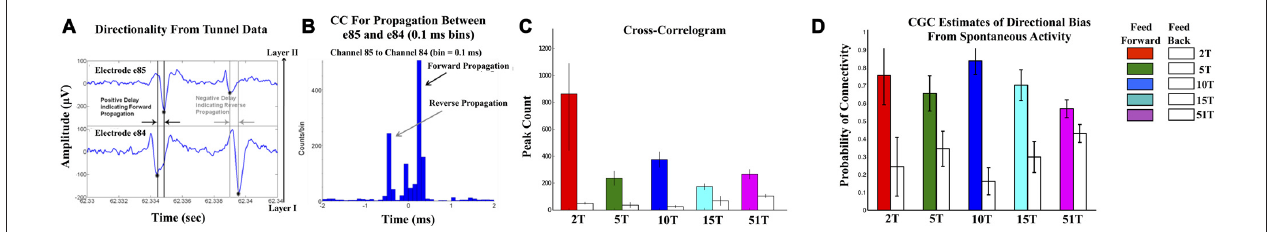
FIGURE 3 | Confirmation of Feed-Forward functional connectivity between Layers I and II. (A,B) illustrate the computation of correlation metric (CC) in which the relative timing of spikes measured from electrode pairs (top and bottom of (A) ). With an electrode separation of 200 µ m and expected conduction velocities between 0.2 and 0.8 m/s (Patolsky et al., 2006), any significant peaks should appear at delays between 0.2 and 0.8 ms. In each CC spikes were accumulated in 0.1 ms bins in a window ± 2 ms surrounding each spike in the reference train. (B) shows an example of the CC computed from the electrode pair 84 and 85 (column 8 and row 4) located along a tunnel in the 51T group. Forward propagation manifests as a peak in CC at positive time lags that is higher than any peaks in the reverse direction. Peaks and inferred direction were computed for each electrode-tunnel-pair in the 2T, 5T, 10T, 15T, and 51T groups and proportion of feed-forward vs. feedback connections calculated. (C) plots the results of that calculation in terms of normalized frequency of feed-forward (colored bars) vs. feedback connectivity for each group. Feed-forward connections were observed significantly more often than feedback in each group. We also computed the conditional Granger causality (CGC) metric on spike train data. (D) The results of our CGC analysis of spontaneous were consistent with those from CC with the majority of connectivity extending from neurons in Layer I into Layer II through the tunnels with low levels of feed-back.